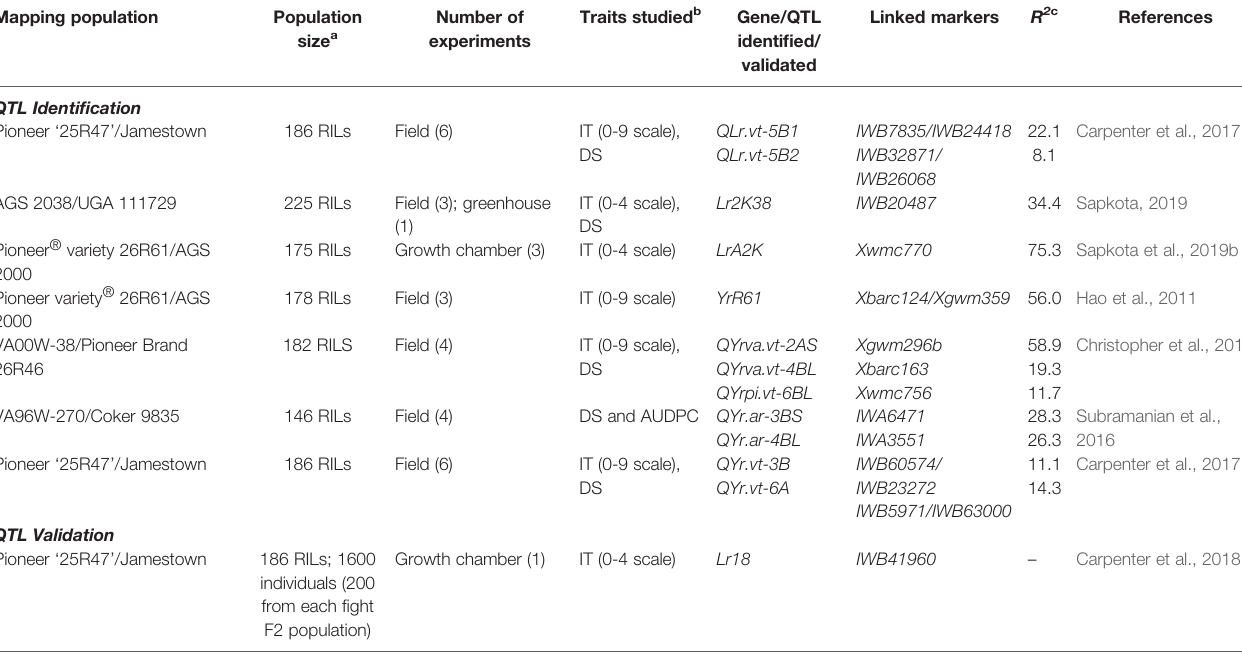
TABLE 4 | Summary of recently identi fi ed QTL for LR and SR resistances and their validation in SRWW in the southeast